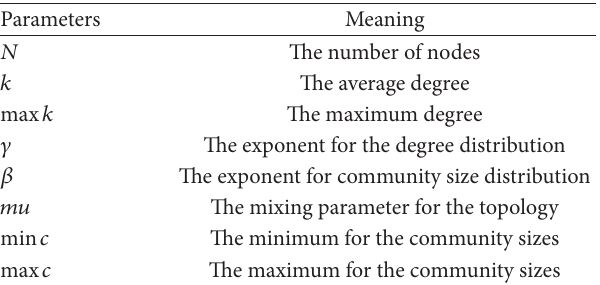
Table 3: The parameters of six groups of LFR